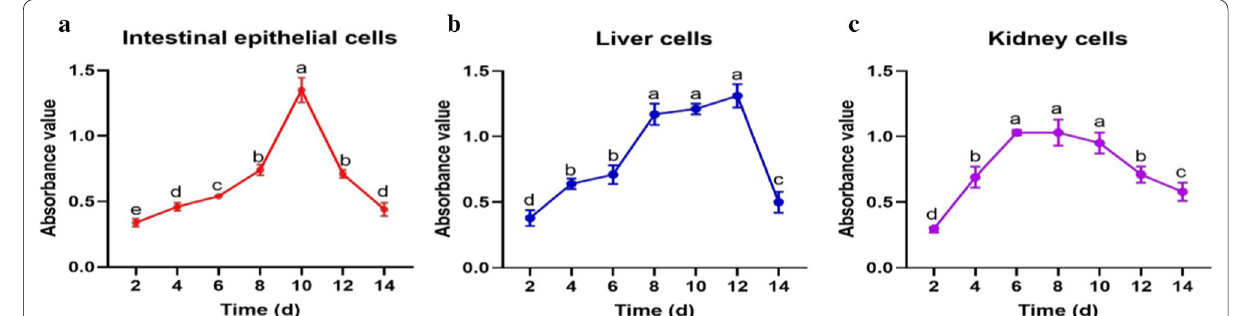
Fig. 1 The growth curves of primary intestinal epithelium, liver and kidney cells (n from each other ( p < 0.05), while the same lowercase letters indicate insignificant difference from each other ( p > 0.05)